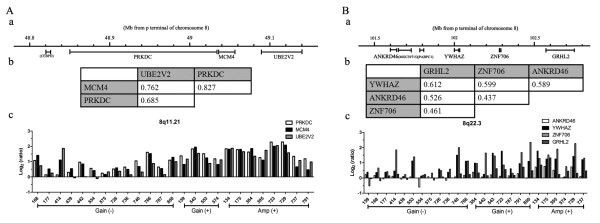
Concordant deregulation of candidate genes at 8q11.21 and 8q22.3. Expression of candidate genes located adjacent to MCM4 at 8q11.21 (A) and YWHAZ at 8q22.3 (B) shows the same trends as that of MCM4 and YWHAZ, respectively. (a) Schematic genome structures of neighboring candidate genes at 8q11.21 and 8q22.3; (b) Pearson’s correlation coefficients of expression log ratios among candidate genes; (c) Expression log ratio of the individual gene in each sample. Gain (−)/Gain (+) was referred to samples with or without gain at 8q11.21 or 8q22.3; Amp (+) was referred to samples with amplification at 8q11.21 or 8q22.3.